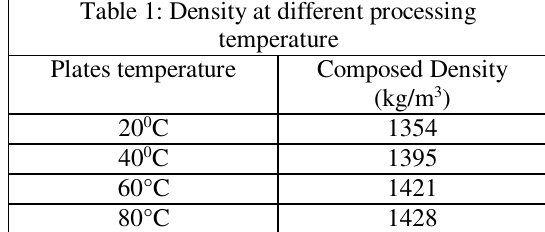
σ = ((cid:9)) # *#$ (cid:23) σ is the bending or flexural strength, P is the applied #